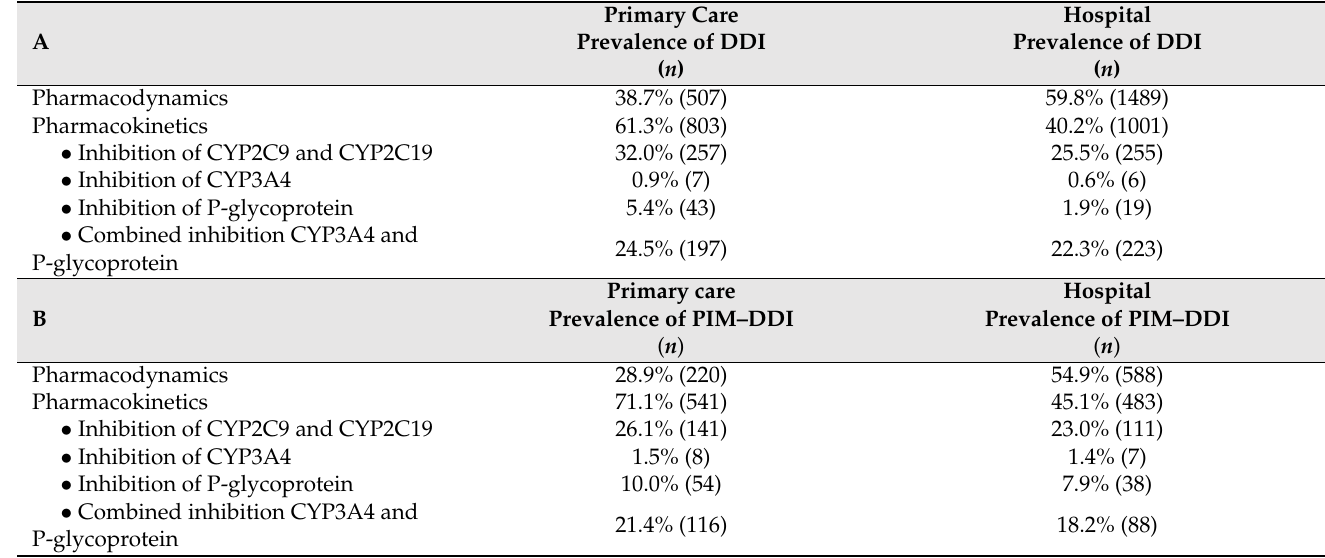
Table 3. Main mechanisms of DDI (A) and PIM–DDI (B) and their prevalence in hospitalized patients treated by oral anticoagulants in primary care and/or during their hospitalization. Combined inhibi- tion CYP3A4 and P-glycoprotein refers to inhibition induced by amiodarone, verapamil, diltiazem, ciclosporin or dronedarone on apixaban and